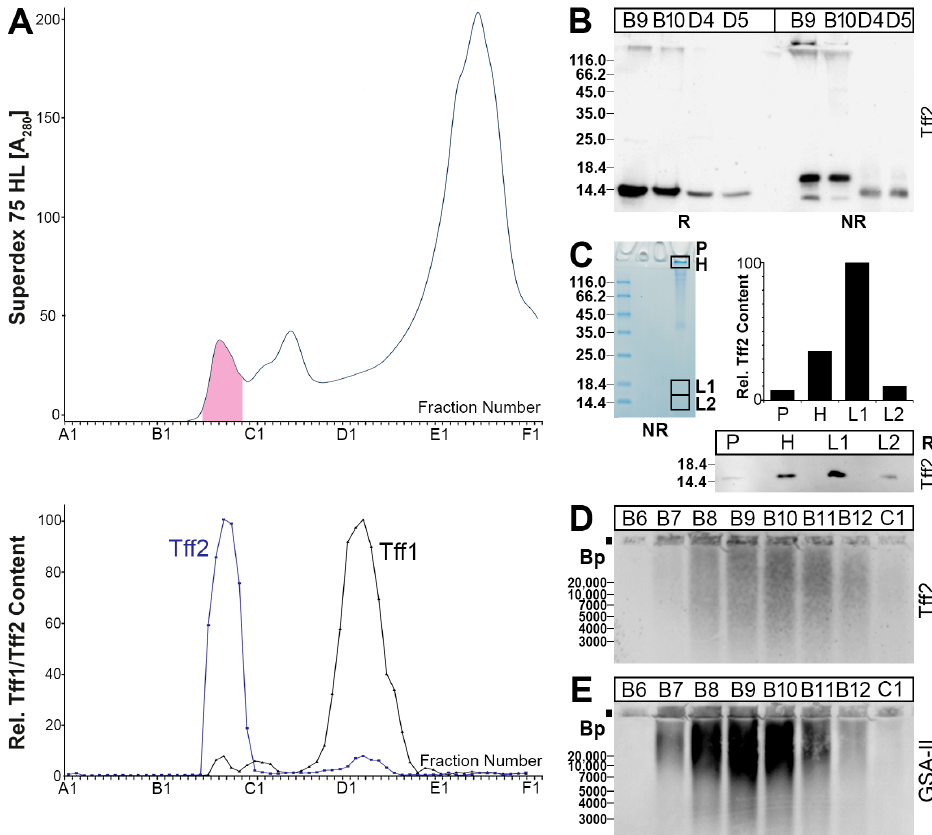
Figure 2. Analysis of a murine gastric extract (5 animals). ( A ) Elution profile after SEC (Superdex 75 HL) as determined by absorbance at 280 nm (PAS-positive mucin fractions: pink). Underneath: Distribution of the relative Tff1 (black) and Tff2 contents (blue) as determined by Western blot analysis under reducing conditions and semi-quantitative analysis of the monomeric band intensities. ( B ) 15% SDS-PAGE under reducing (R) and non-reducing (NR) conditions, respectively, and Western blot analysis of the high-molecular-mass fractions B9 and B10, as well as the low-molecular-mass fractions D4 and D5 concerning Tff2. ( C ) Non-reducing 15% SDS-PAGE of fraction B10 and Coomassie staining. The high- (H) and low-molecular-mass regions (L1, L2) were excised, proteins eluted, and subjected to reducing SDS-PAGE. The samples not entering the gel were removed from the gel pocket (P) and subjected to reducing SDS-PAGE. Western blot analysis concerning Tff2 of P, H, L1, and L2 and relative Tff2 content. ( D , E ) 1% AgGE and Western blot analysis of fractions B6–C1 concerning Tff2 ( D ) or Muc6 (lectin GSA-II, ( E )). Relative standard: DNA ladder (base